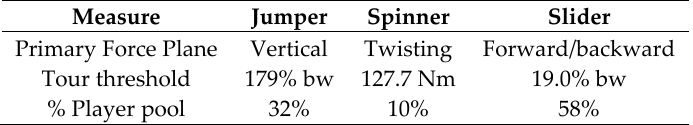
Table 3. Force production cluster measure, where BW is body weight.